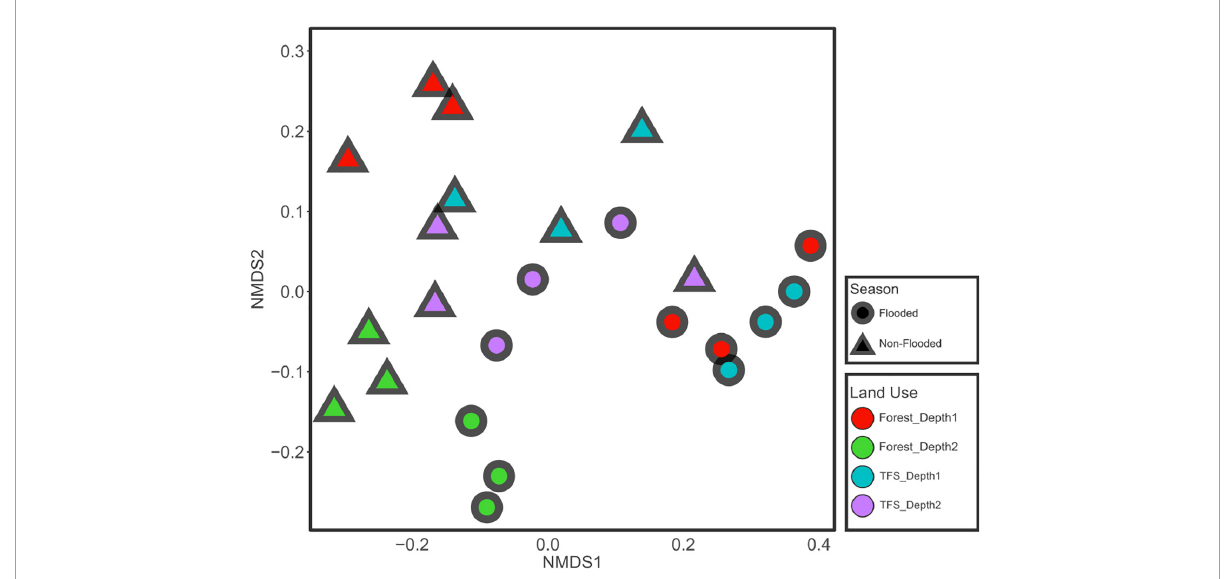
FIGURE1 Clustering of soil chemical properties during different seasons (flood and non-flood) and different combinations of sites and depths. The plot is based on nonmetric multidimensional scaling (NMDS) using the Euclidean distance index.